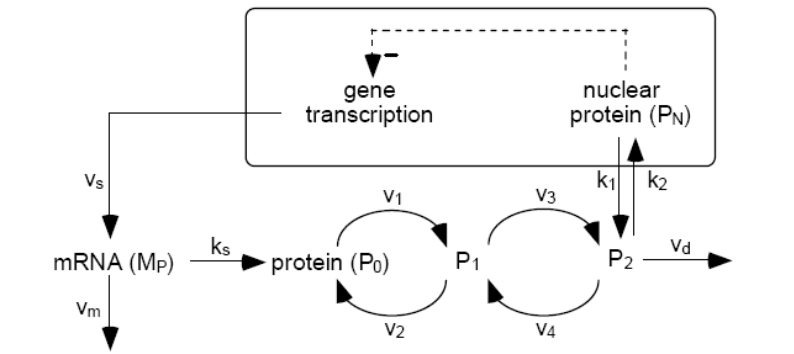
Figure 7. Molecular model for circadian oscillations during genetic expression based on negative self-regulation of the PER gene by its protein product PER. The model incorporates gene transcription into PER mRNA, transport of PER mRNA (M cytosol as well as mRNA degradation, synthesis of the PER protein at a rate proportional to the PER mRNA level, reversible phosphorylation and degradation of PER (P as well as transport of PER into the nucleus (P PER gene. Reproduced with permission from PNAS